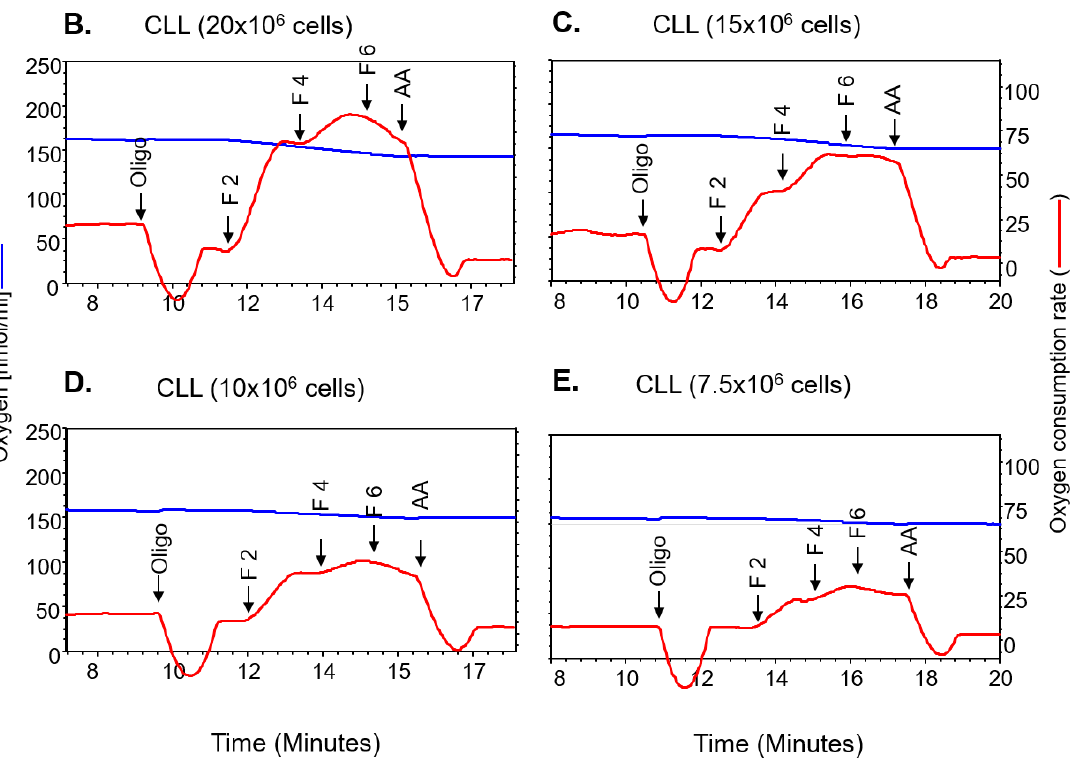
Figure 1. Titration of chronic lymphocytic leukemia (CLL) cell numbers by the Seahorse analyser and Oroboros oxygraph. Freshly isolated CLL cells (6 × 10 5 , 7 × 10 5 , 8 × 10 5 , 9 × 10 5 , and 10 × 10 5 ) were plated to measure the oxygen consumption rate (OCR) by the XF24 Seahorse analyser. ( A ) Cells with subsequent additions of oligomycin (oligo, 1.25 µM), carbonyl cyanide-p-trifluoro-methoxyphenylhydrazone (FCCP) (2 µM), and rotenone (Rot. 1 µM)/antimycin A (AA, 1 µM). For the Oroboros oxygraph, 20 × 10 6 ( B ), 15 × 10 6 ( C ), 10 × 10 6 ( D ), and 7.5 × 10 6 ( E ) cells were added to the chamber to measure the OCR, with subsequent additions of oligomycin (oligo, 2 µM), FCCP (F2–6, 2–6 µM), and antimycin A (AA, 2 µM). Blue line indicates the level of oxygen (nmol/ml, left Y-axis) and red line indicates the oxygen consumption rate (OCR (pmol O 2 /s/indicated amount of cells, right Y- axis)).